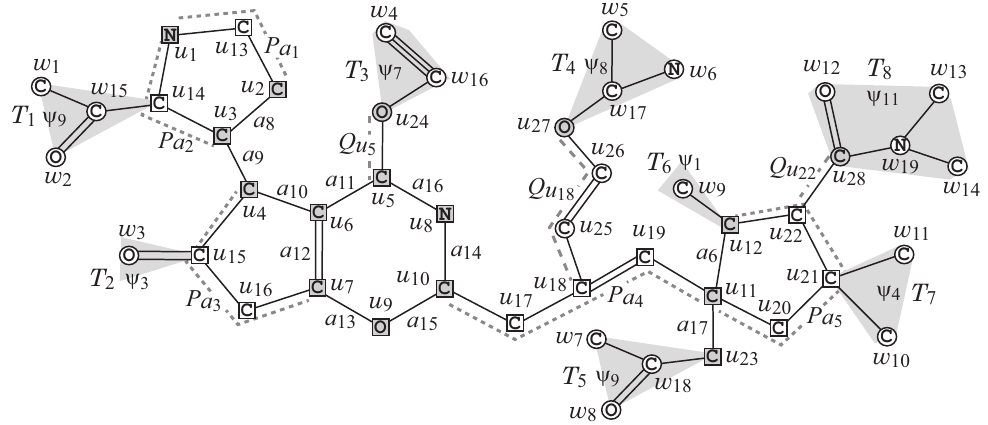
Figure 2. An illustration of a chemical graph G , where for ρ = 2, the exterior-vertices are w 1 , w 2 , . . . , w 19 and the interior-vertices are u 1 , u 2 , . . . , u 28